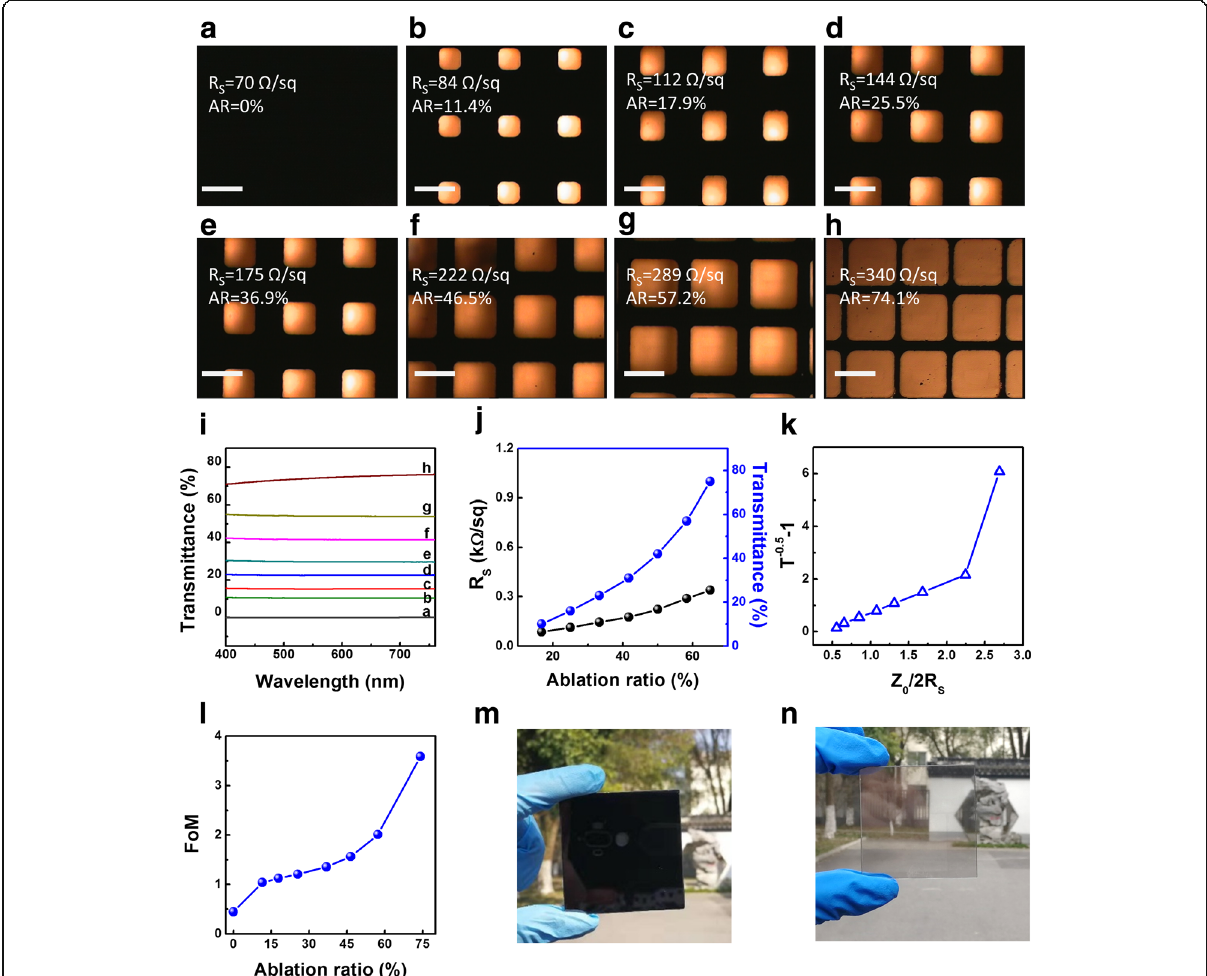
Fig. 3 Characterization of MGFG with different ablation ratio. a – h Microscope images of MGFG with different ablation ratio. Scale bars 200 μ m. i Transmittance of MGFG with different ablation ratio. j Comparison of the sheet resistance and transmittance of MGFG with different ablation ratio. k T and R S data for MGFG with different ablation ratio. l FoM of MGFG with different ablation ratio. m , n Photographs of 5 cm × 5 cm graphene film sample before and after laser